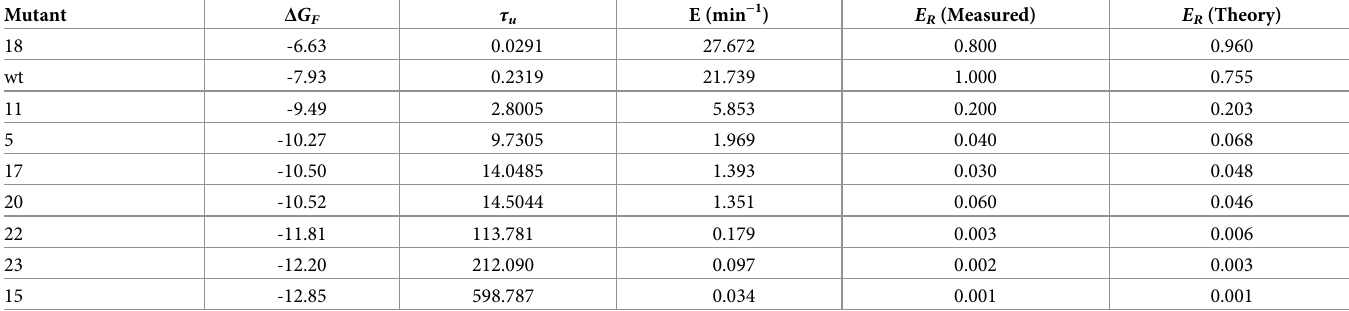
Table 1. Predicted and measured relative coat protein expression in bacteriophage MS2 for different coat hairpin mutants. The relative coat protein expression ( E R ) of hairpin mutants are shown relative to the peak protein expression. Measured values of E R are obtained from [13], while theoretical values are from Eq 2. The hairpin unfolding times τ = e − β Δ G / k are estimated using a hairpin folding rate of k u F energy parameters at T = 315K (42˚C) [21].